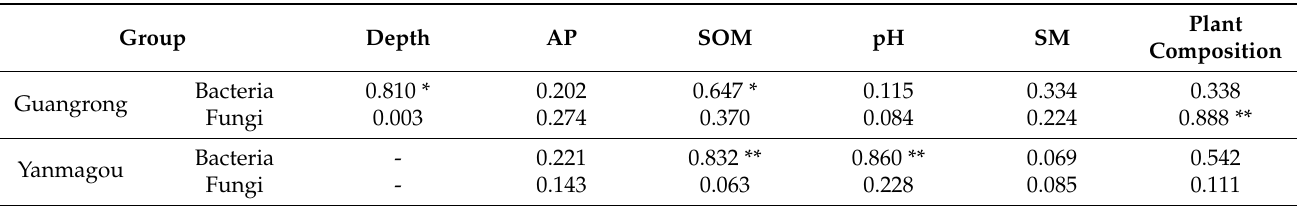
Table 2. RDA analysis of soil bacterial and fungal community composition in gullies at Guangrong and Yanmagou sites.